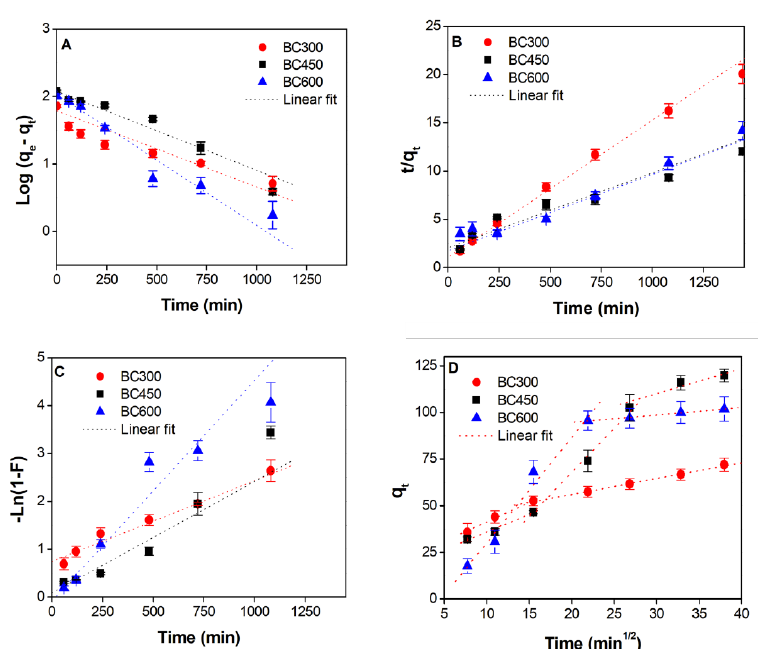
Figure 5. Fitted experimental data with the ( A ) pseudo-first-order model, ( B ) pseudo-second-order model, ( C ) liquid layer diffusion model, and ( D ) intra-particle diffusion for the biochar samples under study (BC300, BC450, and BC600). Table 5. Kinetic parameters calculated from the pseudo-first- and pseudo-second-order models, in addition to the intra-particle diffusion and liquid film diffusion linear models.